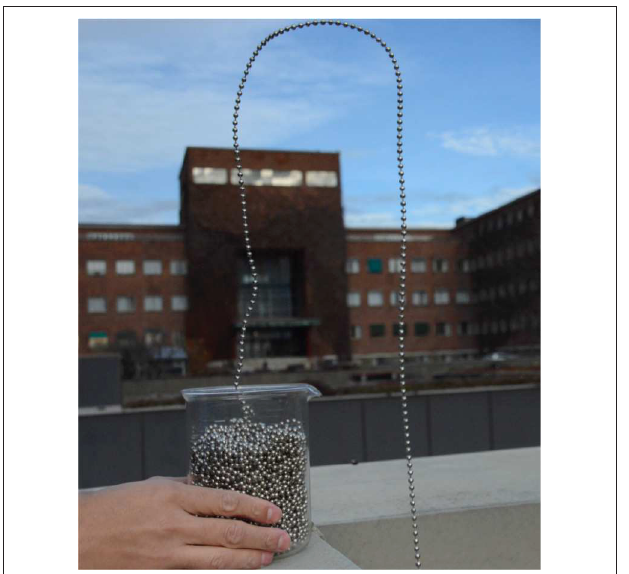
FIGURE 1 | The flying chain resulting from a 5 m drop of the chain, photographed outside the physics building at the University of Oslo.